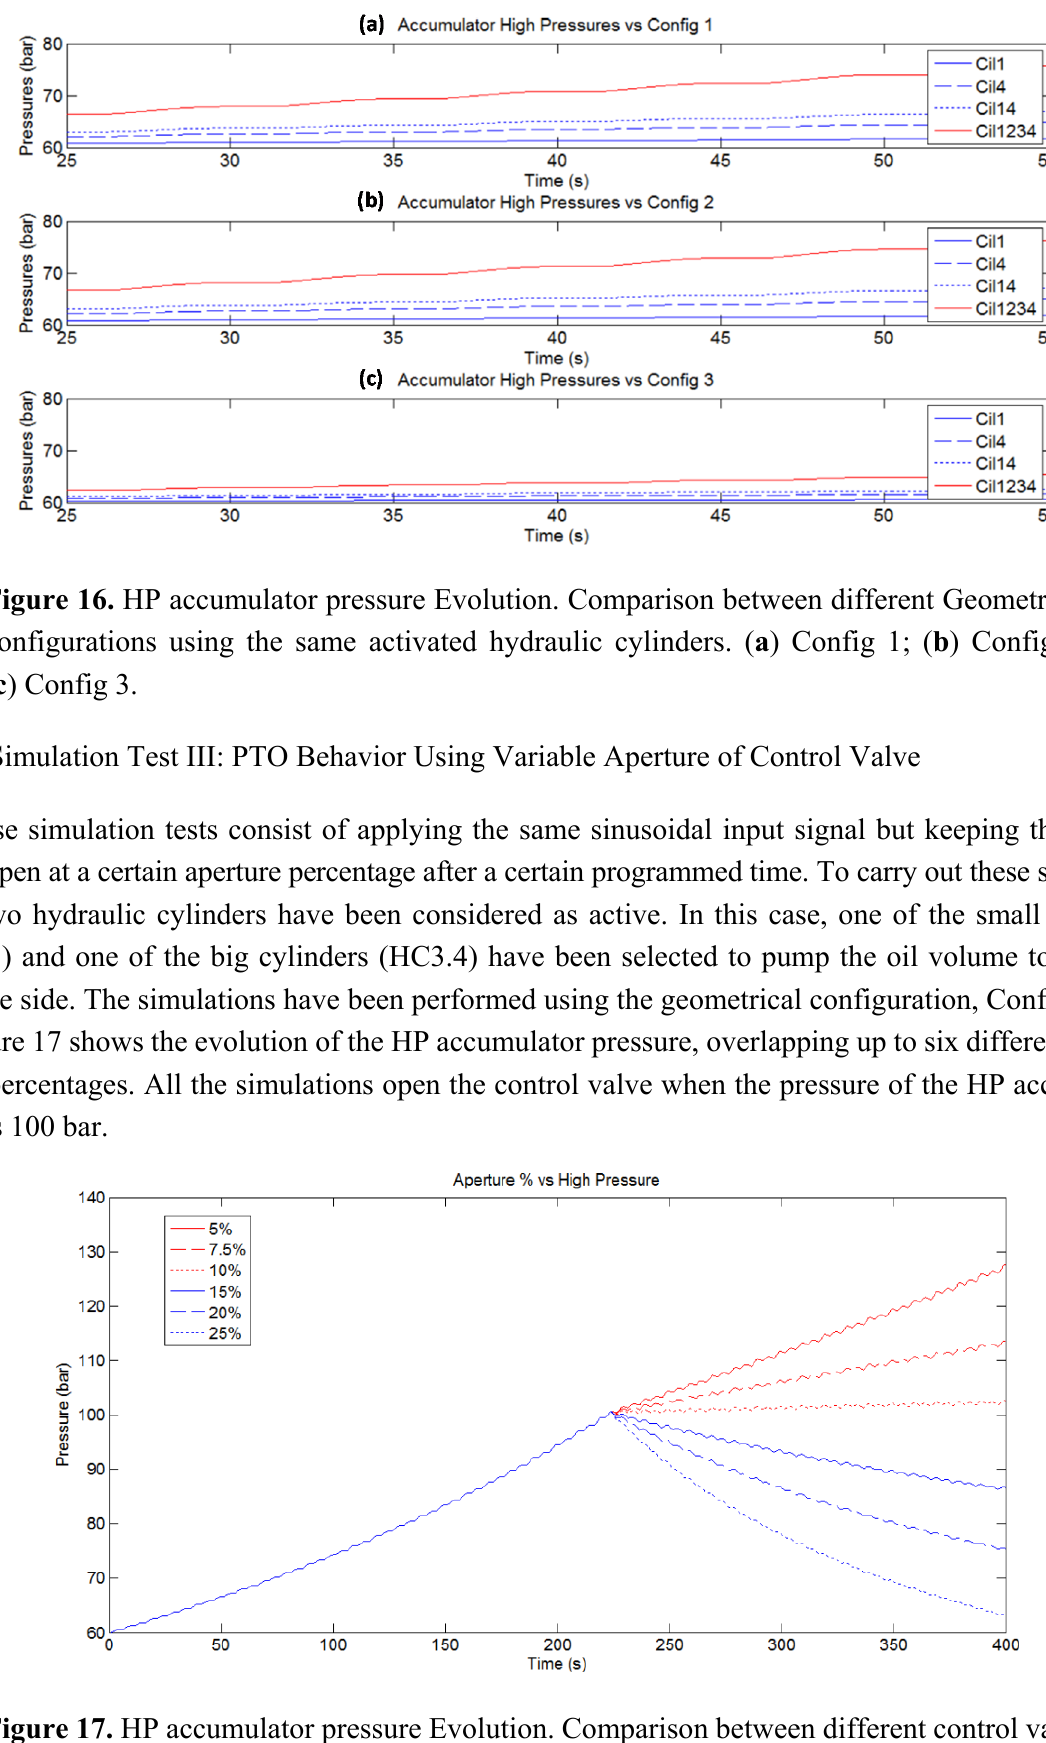
Figure 17. HP accumulator pressure Evolution. Comparison between different control valve apertures using the same activated hydraulic cylinders (HC3.1 and HC3.4). Config